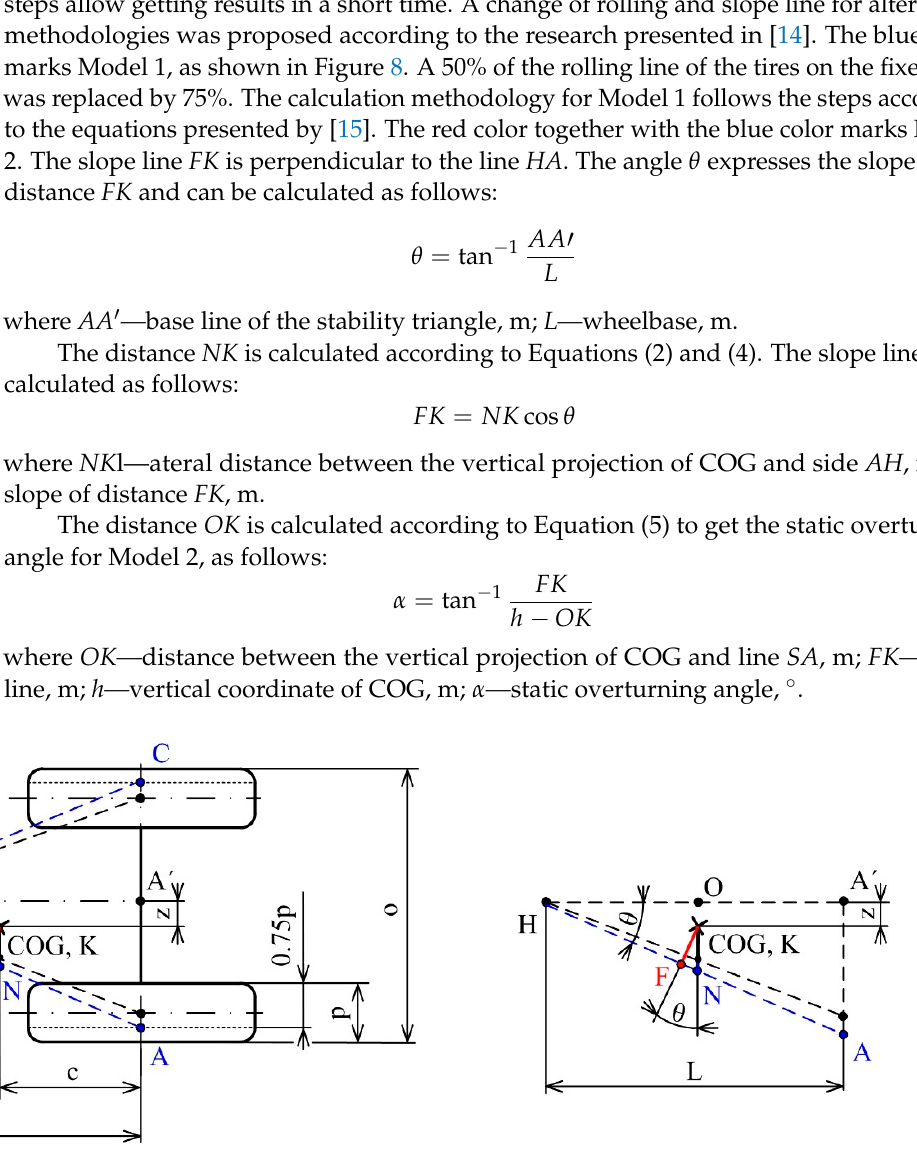
Figure 8. Scheme for Models 1 and 2 based on the modification of [15]: L— wheelbase; c, d— longitudinal coordinates of COG; z— lateral position of COG; AA’— base line of the stability triangle ; NK— slope line for Model 1; FK— slope line for Model 2.